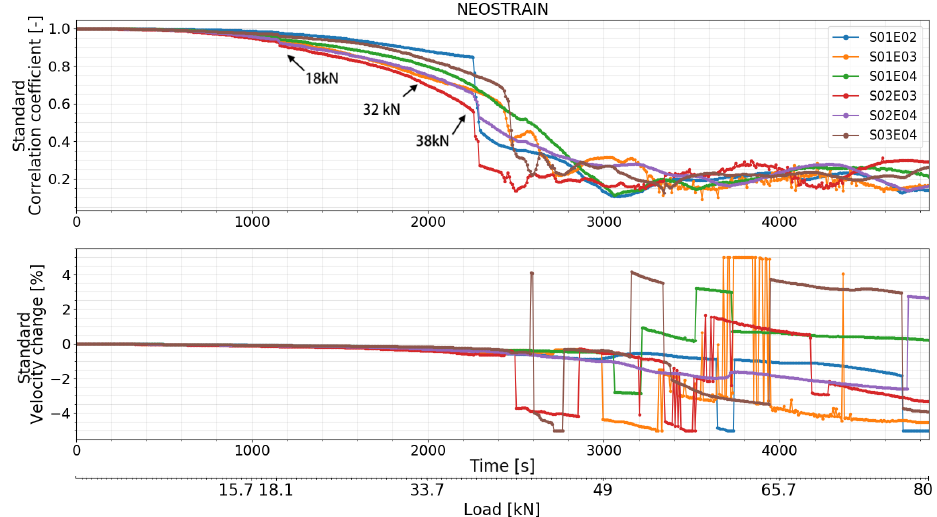
Figure 18. Correlation coefficient and relative velocity change of all the transducers combinations in test at NEOSTRAIN calculated by standard CWI.